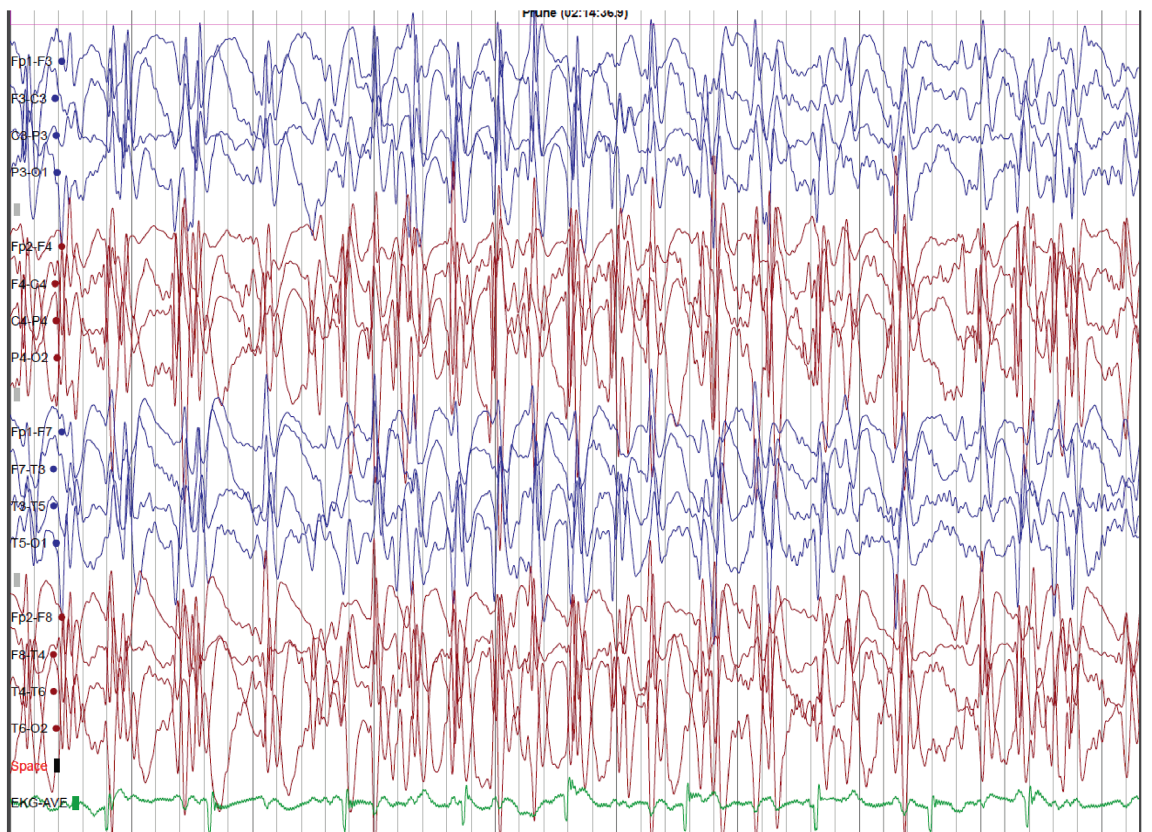
Figure 2: Abnormal EEG showing electrical status following increased carbamazepine dose (voltage